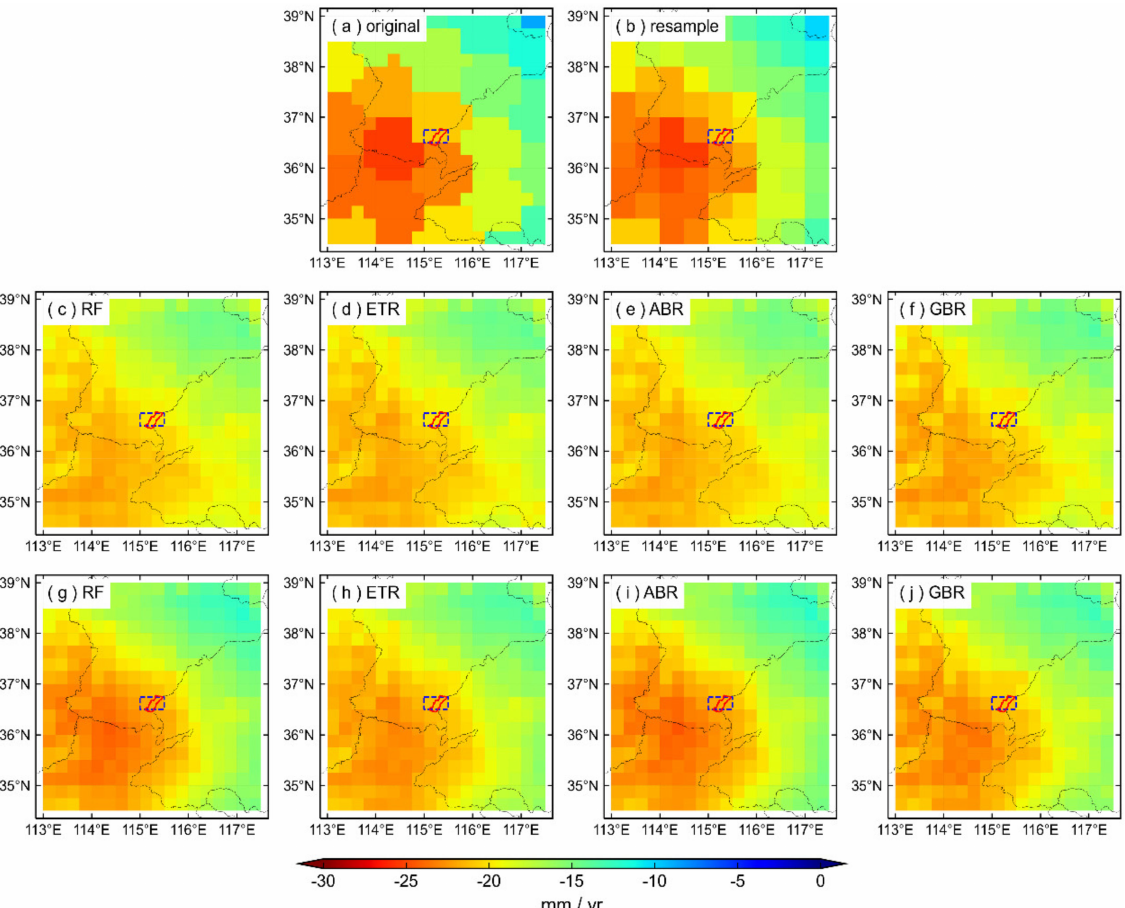
Figure 5. The spatial distribution of the TWSA trends before and after downscaling (take WS9 as an example); ( a ) is the original signal of CSR-M06; ( b ) is the signal of ( a ) resampled to 0.5 ◦ ; ( c – f ) is the result of downscaling the ( b ) signal using four machine learning algorithms (without adding residuals); ( g – j ) are the downscaled results of ( c – f ) after adding the